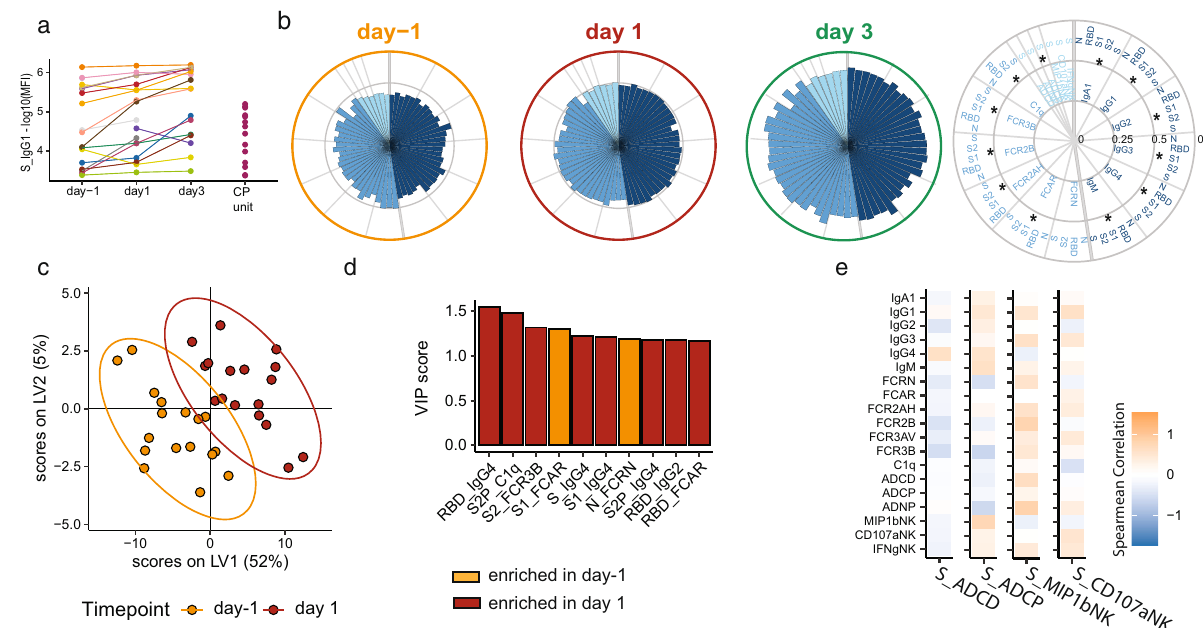
Fig. 3 SARS-CoV-2-speci fi c antibody pro fi les globally increased in severe COVID-19 CP recipients. CP recipients were pro fi led for SARS-CoV-2-speci fi c antibody responses from 1 day before receiving CP (day − 1) to 1 and 3 days after receiving CP. a SARS-CoV-2S-speci fi c IgG1 titers of COVID-19 patients at day − 1 ( n = 18), day 1 ( n = 18), and day 3 ( n = 16), and 14 CP units. Values are reported as log10 median fl uorescence intensity (MFI). b The polar plots depict the mean percentiles of SARS-CoV-2-speci fi c antibody features within the day − 1 (n = 18), day 1 ( n = 18), and day 3 ( n = 16) groups for the antigens N, RBD, S1, S2, and S. Each wedge represents a SARS-CoV-2 antibody feature, and the size of the wedge indicates the magnitude of the value. The colors represent the feature group: dark blue — antibody isotypes and subclasses; blue — Fc-receptor binding levels; light blue — antibody functions. An asterisk indicates a global two-sided p -value obtained by non-parametric combination (Friedman test p -values for partial tests within each feature type, and Fisher ’ s method for combination, * p < 0.05). c Multi-level partial least squares discriminant analysis (mPLS-DA) scores plot for the fi rst two latent variables. Each dot is one sample, and the ellipses indicate 95% con fi dence regions assuming a multivariate t -distribution. Colors indicate the time point the samples of the n = 17 individual patients were taken (day − 1 and day 1). The model achieved an average cross-validation accuracy of 86%. d Variable importance in projection (VIP) score plot showing the top 10 important antibody features out of the 81 antibody features used to construct the mPLS-DA. The color of the bar indicates in which group the feature is enriched, i.e., has a higher median value. e Heatmap showing the Spearman correlation coef fi cients between increases in antibody levels between day − 1 and day 1 ( y axis) and corresponding donor CP Spike-speci fi c antibody features enriched in CP including ADCD, ADCP, and ADNK activation measured by NK cell expression of MIP-1 β and CD107a. Source data are provided as a Source Data fi